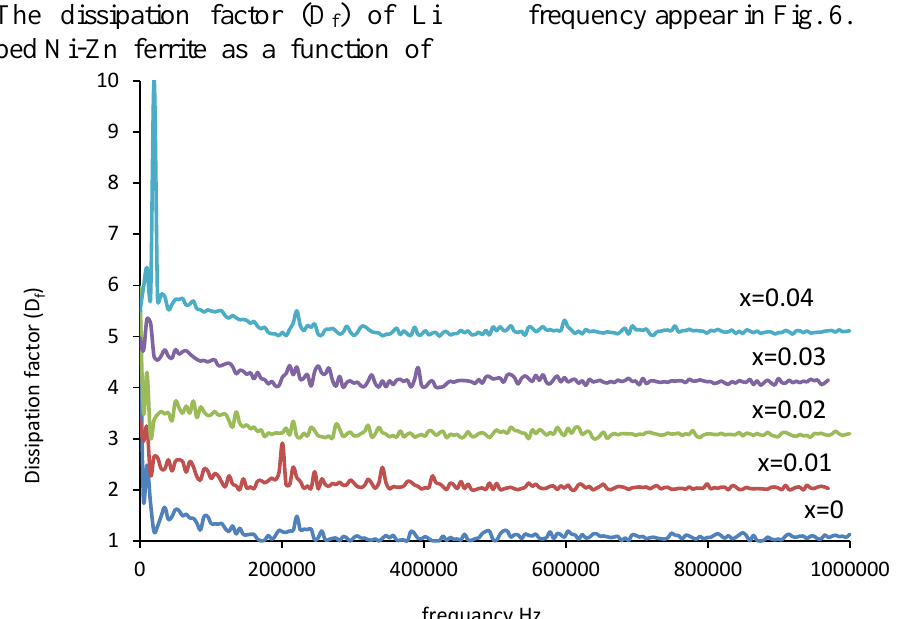
Fig. 6: Variation of dissipation factor with frequency for Ni